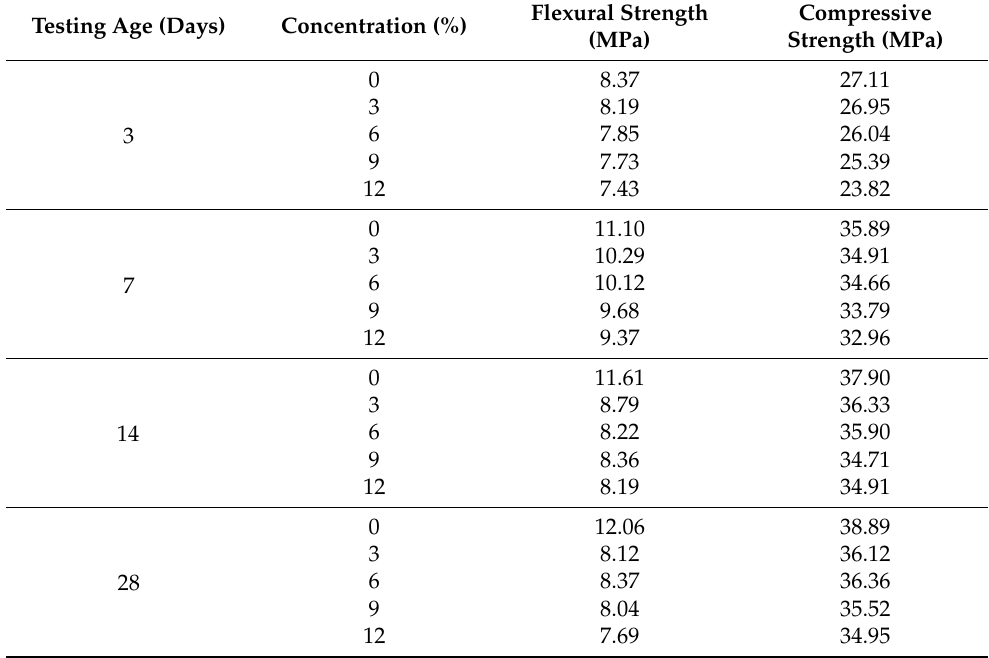
Table 3. The data of flexural and compressive test.